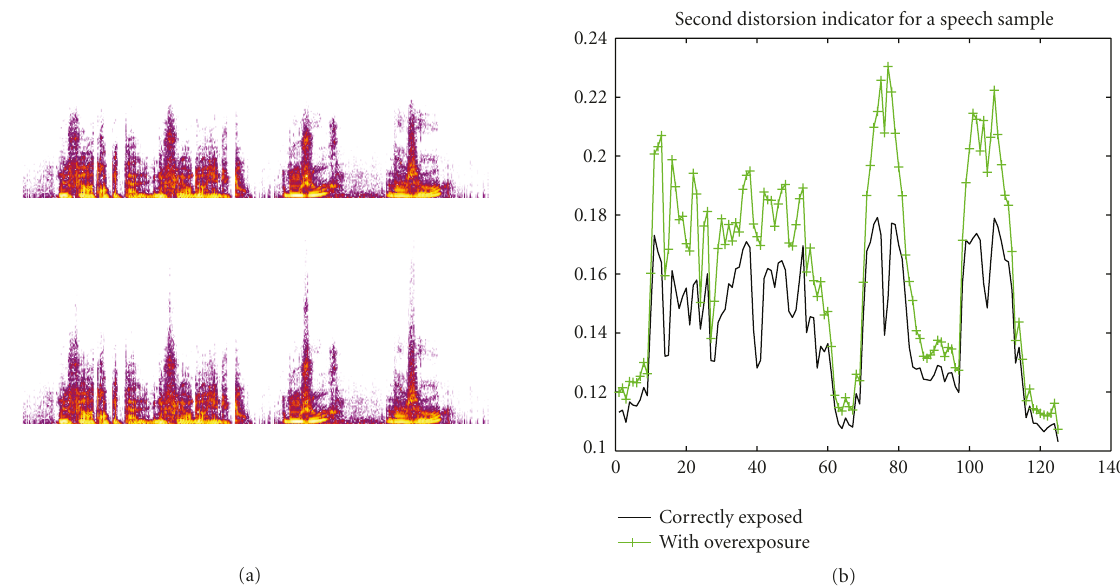
Figure 20: Top left: spectrogram of speech sample (5 seconds), correctly exposed. Bottom left: spectrogram of the same sample after simulation of overexposure. Right: for this sound sample, the HD-indicator is plotted in black for a correctly exposed soundtrack and in green for a overexposed